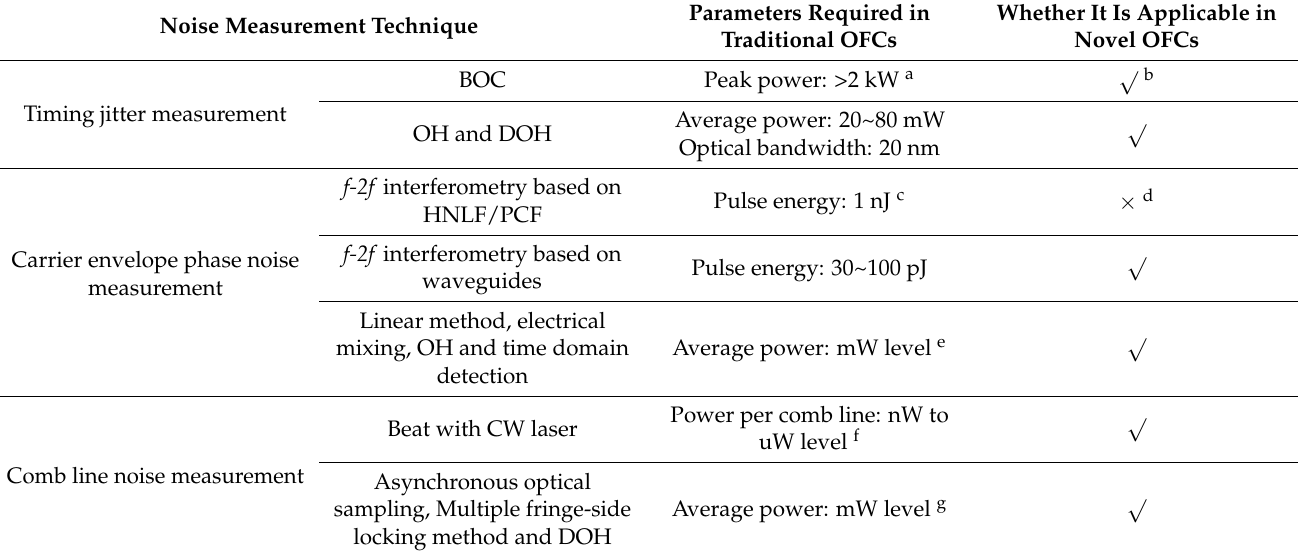
Table 1. Summary of key parameters that required for noise measurement and whether it is applicable in novel OFCs. Parameters Required in Whether It Is Applicable in Noise Measurement Technique Traditional OFCs Novel OFCs √ b BOC Peak power: >2 kW a Timing jitter measurement